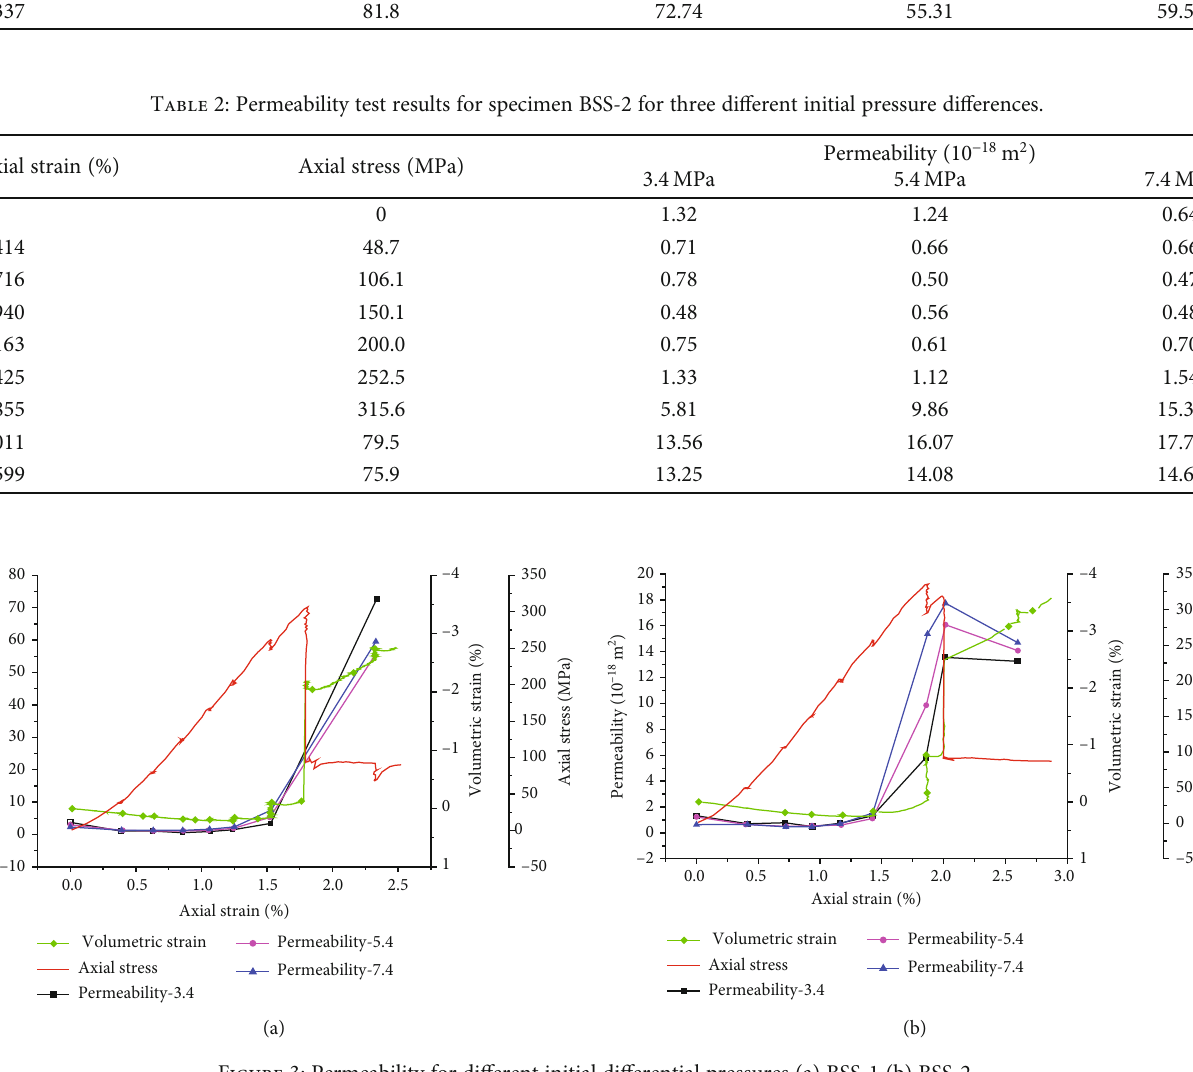
Figure 3: Permeability for di ff erent initial di ff erential pressures (a) BSS-1 (b)